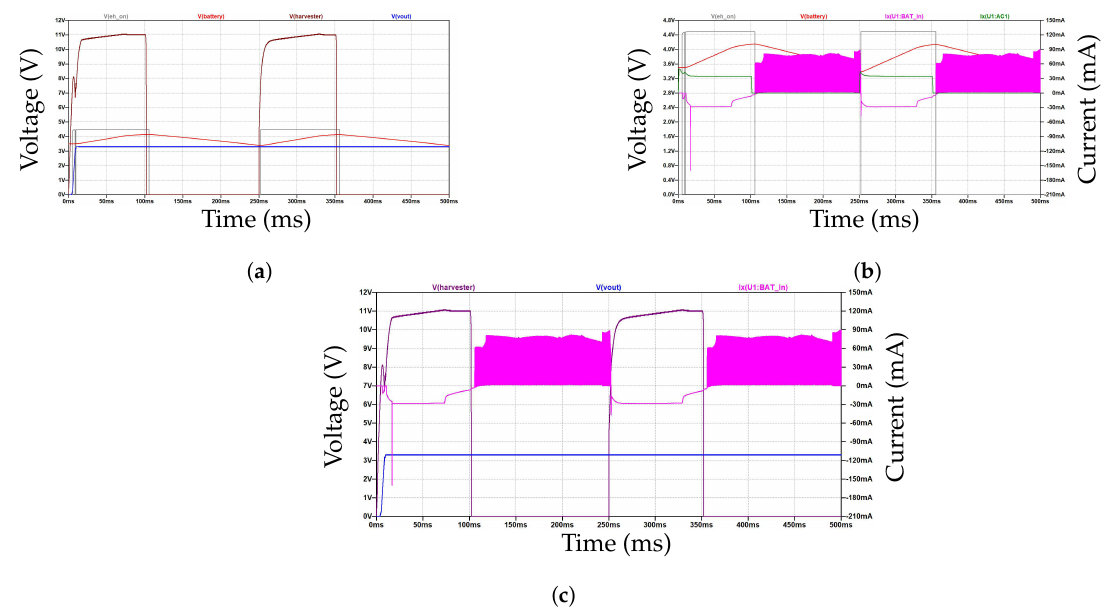
Figure 9. Transient analysis of LTC3331 combined with LTC4071 for 500 ms duration. ( a ) Harvester, battery, output voltage and EH _ ON signal. ( b ) Battery voltage and current flowing through AC 1 and BAT _ IN pins. ( c ) Harvester and output voltage and current flowing through BAT _ IN